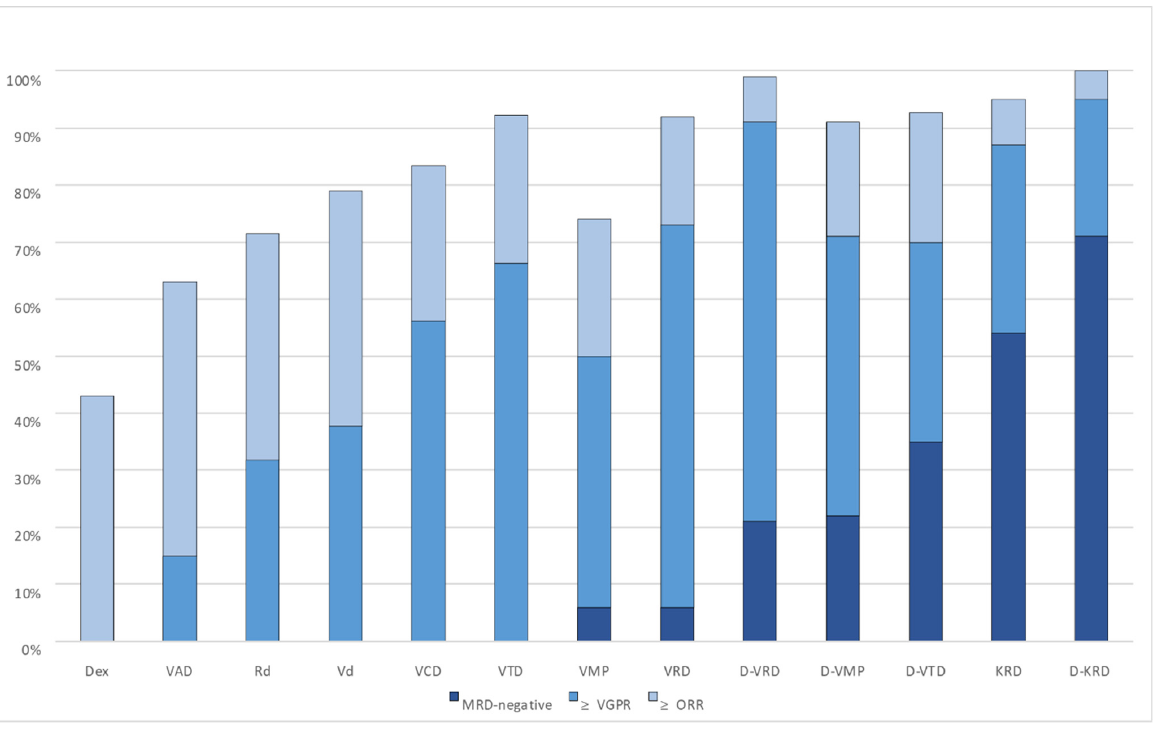
Figure 2. Depth of response and MRD negativity in relation to first ‐ line treatment regimen for multiple myeloma [ 2,3,5,6,13,14,48,55–58] .